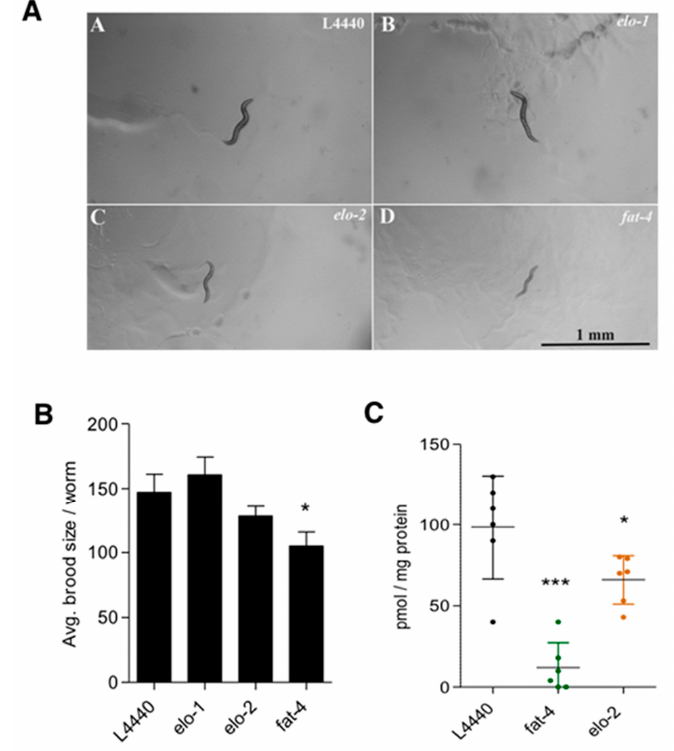
Figure 6. ELO-2 and FAT-4 required for synthesis of JuA. ( A ) shows the effect of RNAi mediated knockdown of elongases and Δ 5 desaturase in fat-3(wa22) animals. elo-2 and fat-4 knockdowns show growth delay after 48 h of hatching at 23 °C as compared L4440 controls (Scale bar = 100 mm). ( B ) A slight decrease in brood size was observed with the elo-2 knockdown. A significant reduction in brood size was observed with the fat-4 know-down (* p < 0.01). Data show mean values ± SD. ( C ) Significant reduction in the levels of JuA after the knockdown of fat-4 (*** p < 0.0001) and elo-2 (* p < 0.01) in fat-3(wa22) animals. All brood size experiments were carried out with n = 5 animals per condition in three independent trials. Scatter plot shows mean ± SD. Cells 2020 , 9 , x